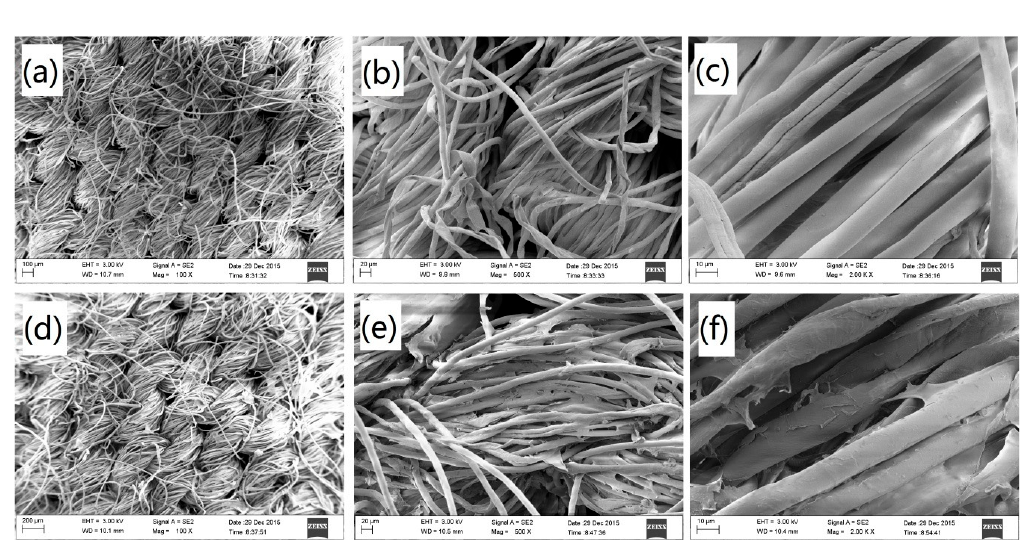
Figure 8. SEM micrographs of unmodified cotton fabric ( a – c ); IPN hydrogel modified cotton fabric ( d – f ).